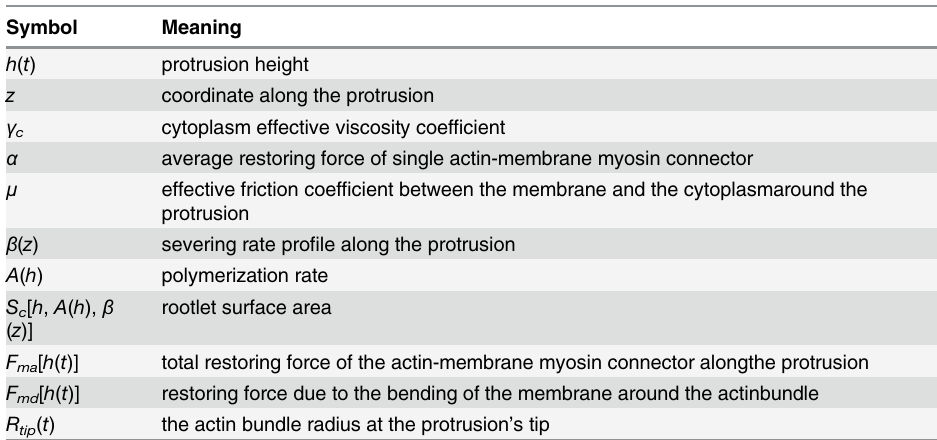
Table 1. List of the variables and parameters used in Eqs 1 and